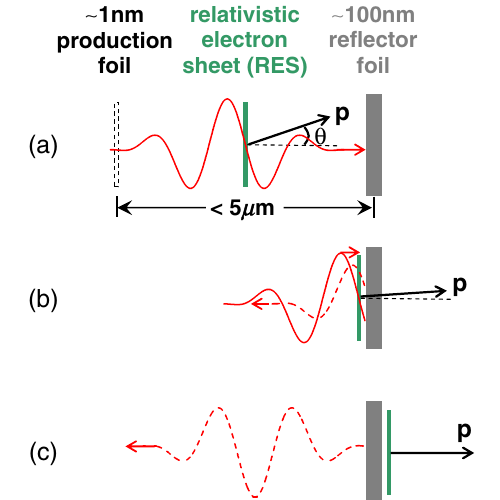
FIG. 1. Scheme for producing the relativistic electron sheet (RES). (a) An intense, normally incident, few-cycle laser pulse (red) has ionized the ultrathin (and therefore transparent) pro- duction foil and has expelled all electrons. They form the RES (green), surfing on the laser pulse. Electron momenta p are tilted relative to the laser propagation axis by an angle (cid:4) due to the transverse component of the laser field. (b) The laser pulse is reflected by the reflector foil (grey) and interacts a second time with the RES. The reflector foil is just thick enough to fully reflect the driving laser pulse, but to let the relativistic electrons pass almost unperturbed. (c) The RES emerges into field-free space behind the reflector. Because of conservation of canonical momentum, electrons now move exactly in normal direction with zero transverse